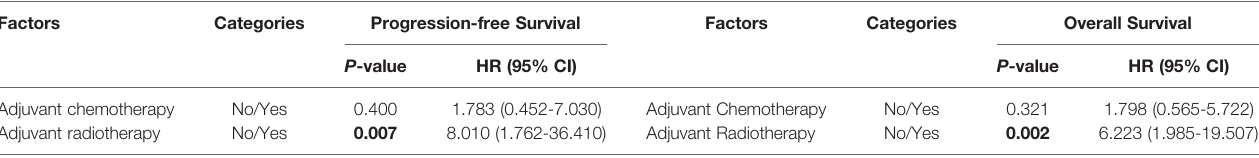
Bold values indicate P <